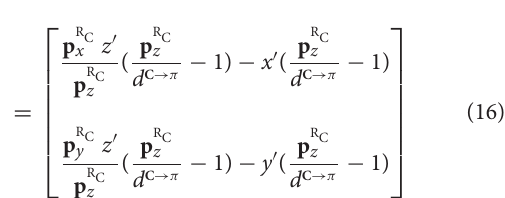
FIGURE 3 | Geometrical representation of the parallax between the calibration position and the viewpoint